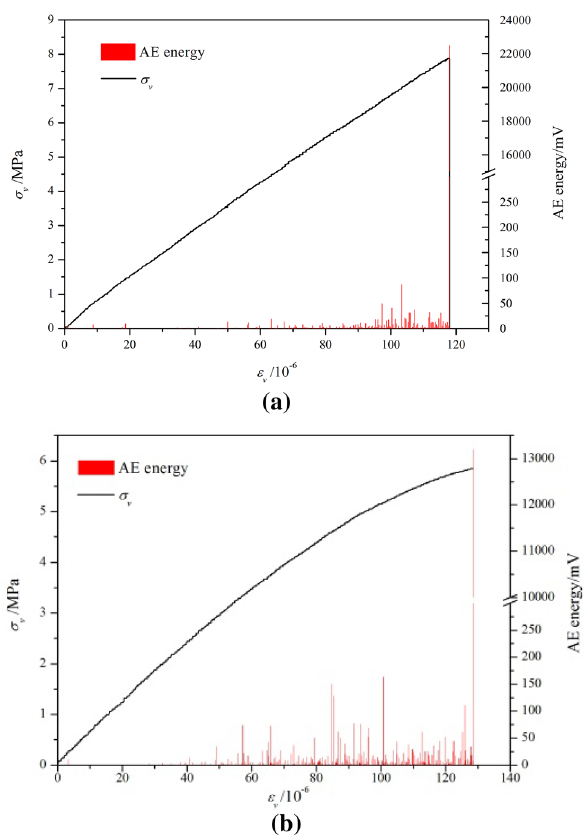
Fig. 5 AE activities during the whole directly tensile process for specimens in B group. a Specimen B2, b specimen B5